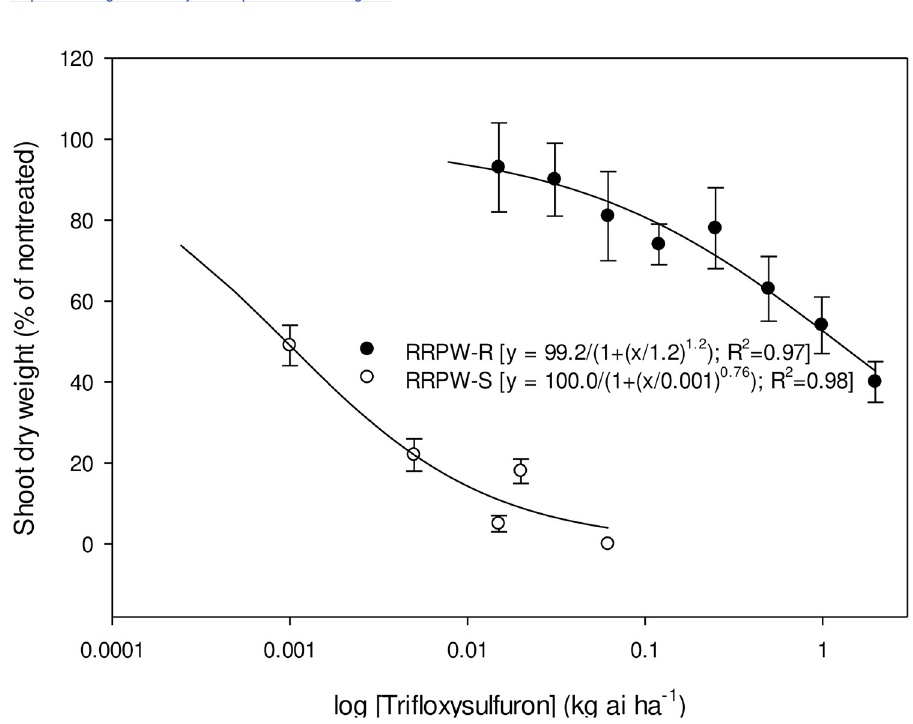
Fig 3. Trifloxysulfuron dose response on shoot dry weight reduction of ALS-inhibiting herbicide-resistant (RRPW-R) and -susceptible (RRPW-S) Amaranthus retroflexus populations from Mississippi 3 wk after treatment. Vertical bars represent standard error of